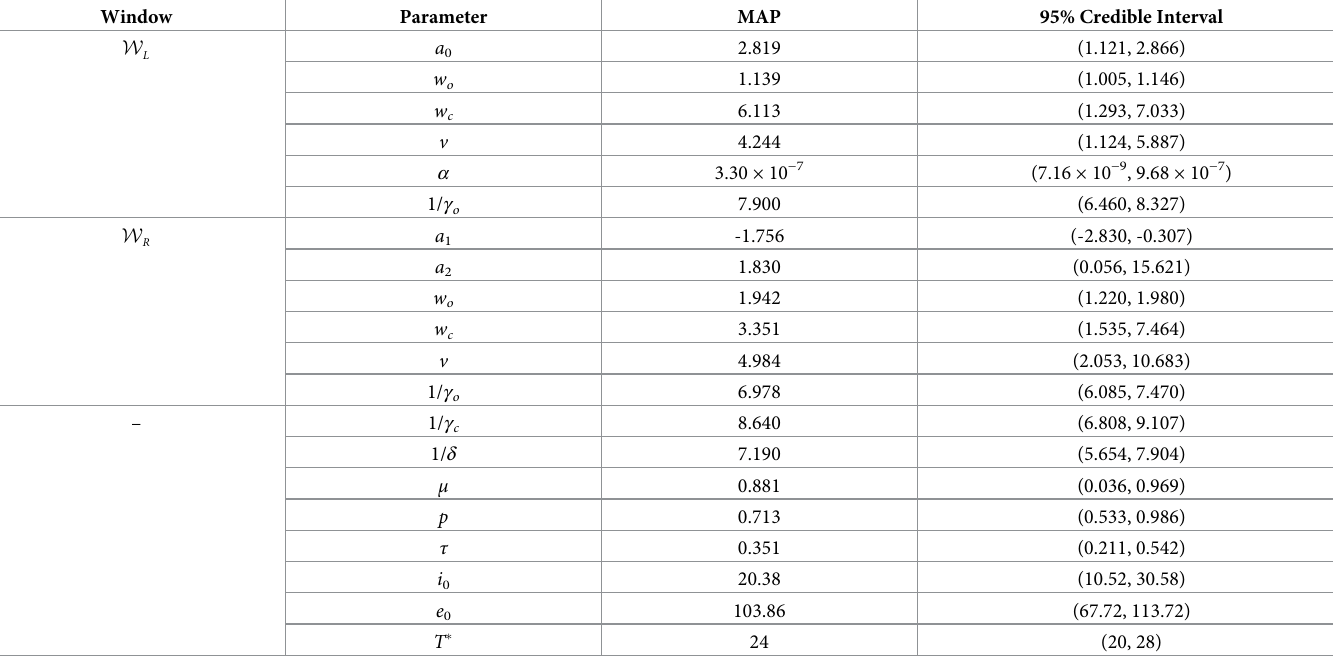
Table 3. MAP estimates and associated credible intervals for